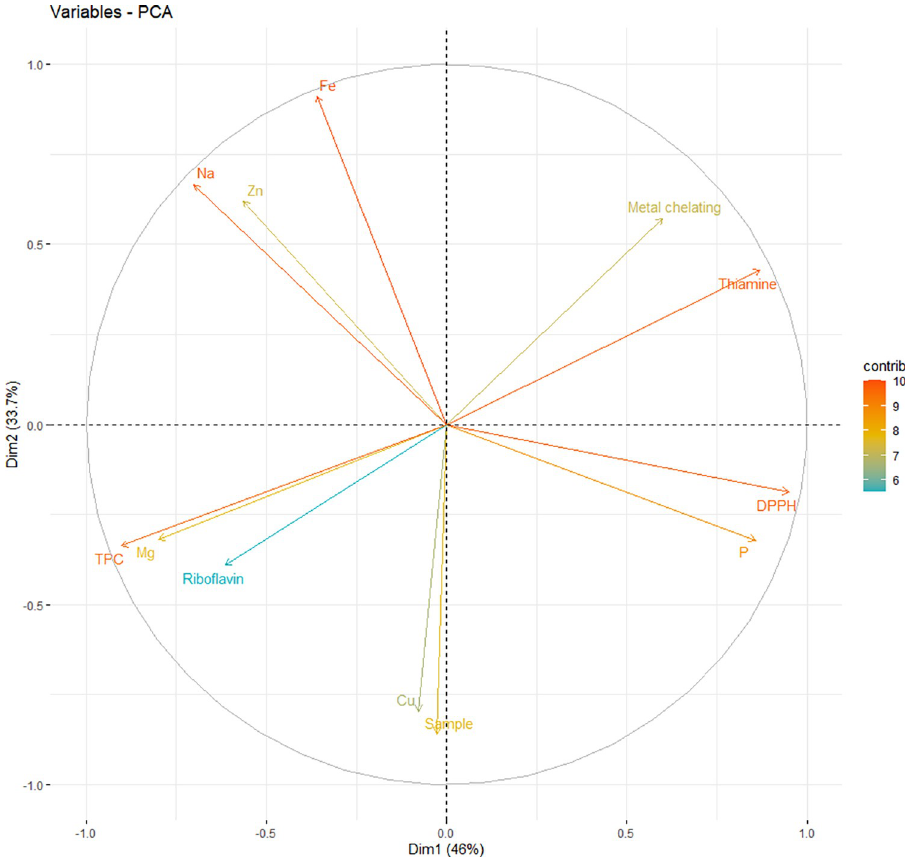
Fig 3. Principal component analysis (PCA) plot of individuals. Legend: Dim1 –principal component 1; Dim2 – principal component 2; contrib—contributions of the individuals to the principal components. Pleurotus ostreatus (Fr.) Kumm., P . pulmonarius (Fr.) Quel., P . columbinus (Fr.) Quel ., P . cor- nucopiae (Pers.) Rolland, P . eryngi (Fr.) Quel., as well as P . sajor-caju [18]. However, irrespec-